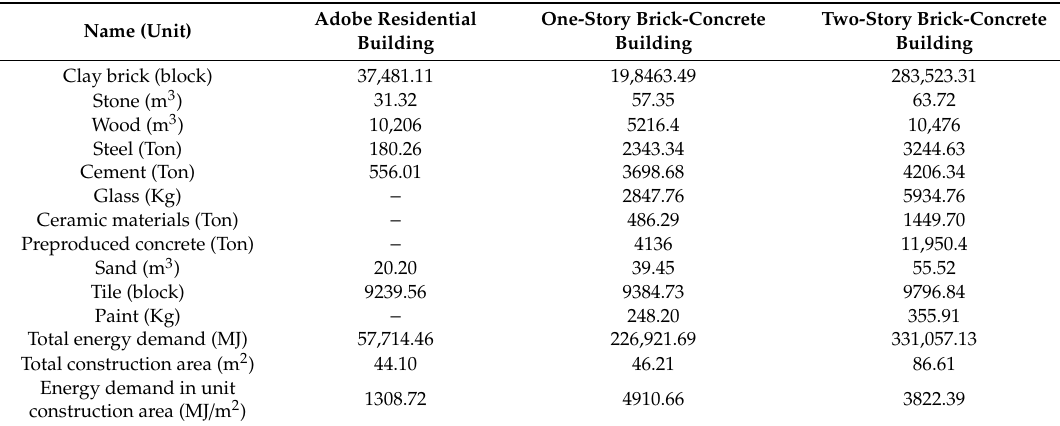
Table 4. Energy demand in manufacture process of di ff erent residential buildings